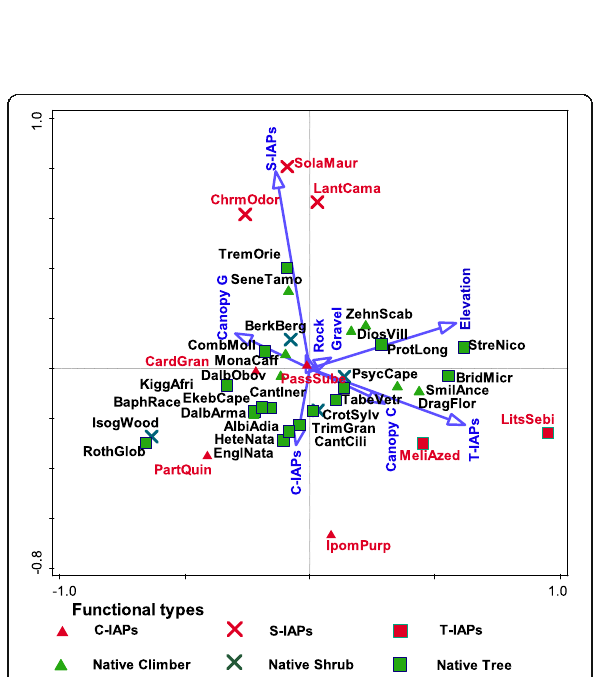
Fig. 5 The plot scale (fine-scale) spatial variables from the Durban Metropolitan Open Space System. Species codes are detailed in Table 3. Blue arrows and corresponding labels represent the environmental factors, while red labels are IAPs and black labels are native